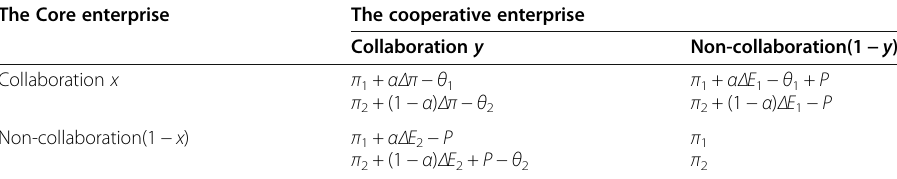
Table 1 Payoff Matrix The Core enterprise The cooperative